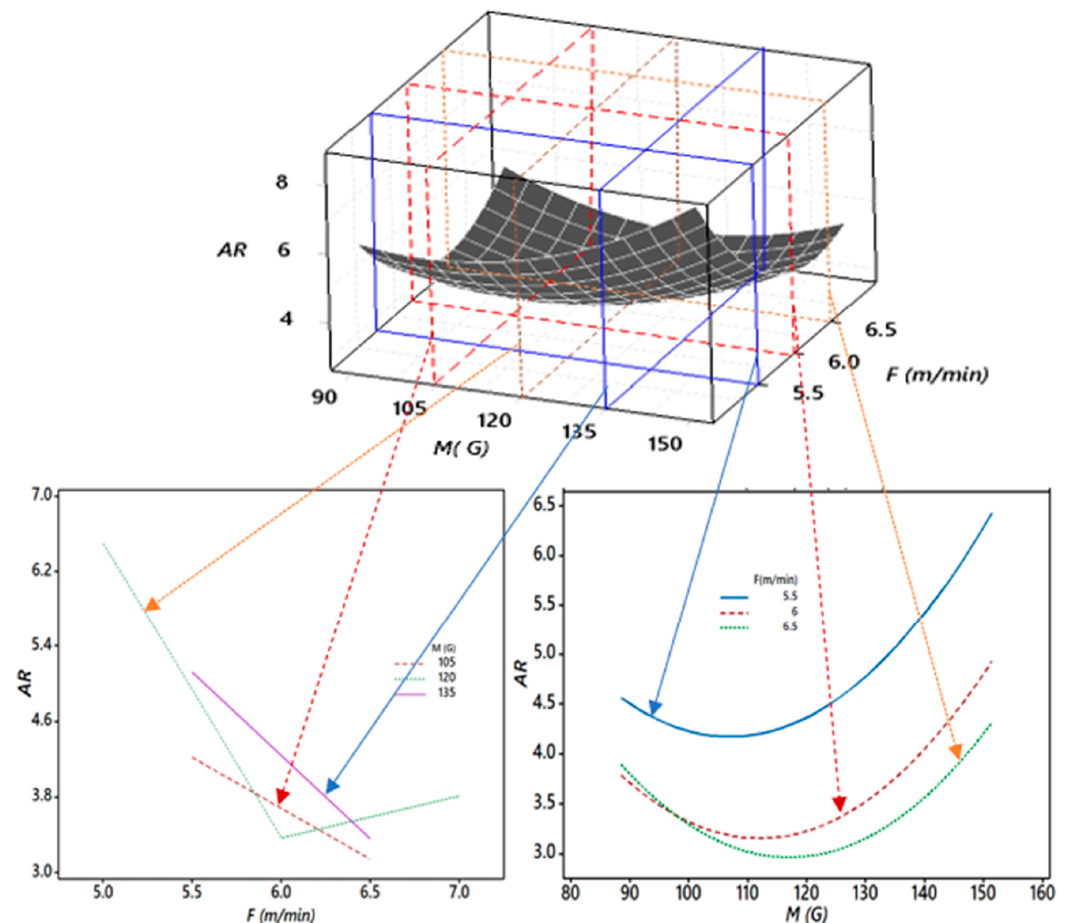
ff ects of M and F on AR